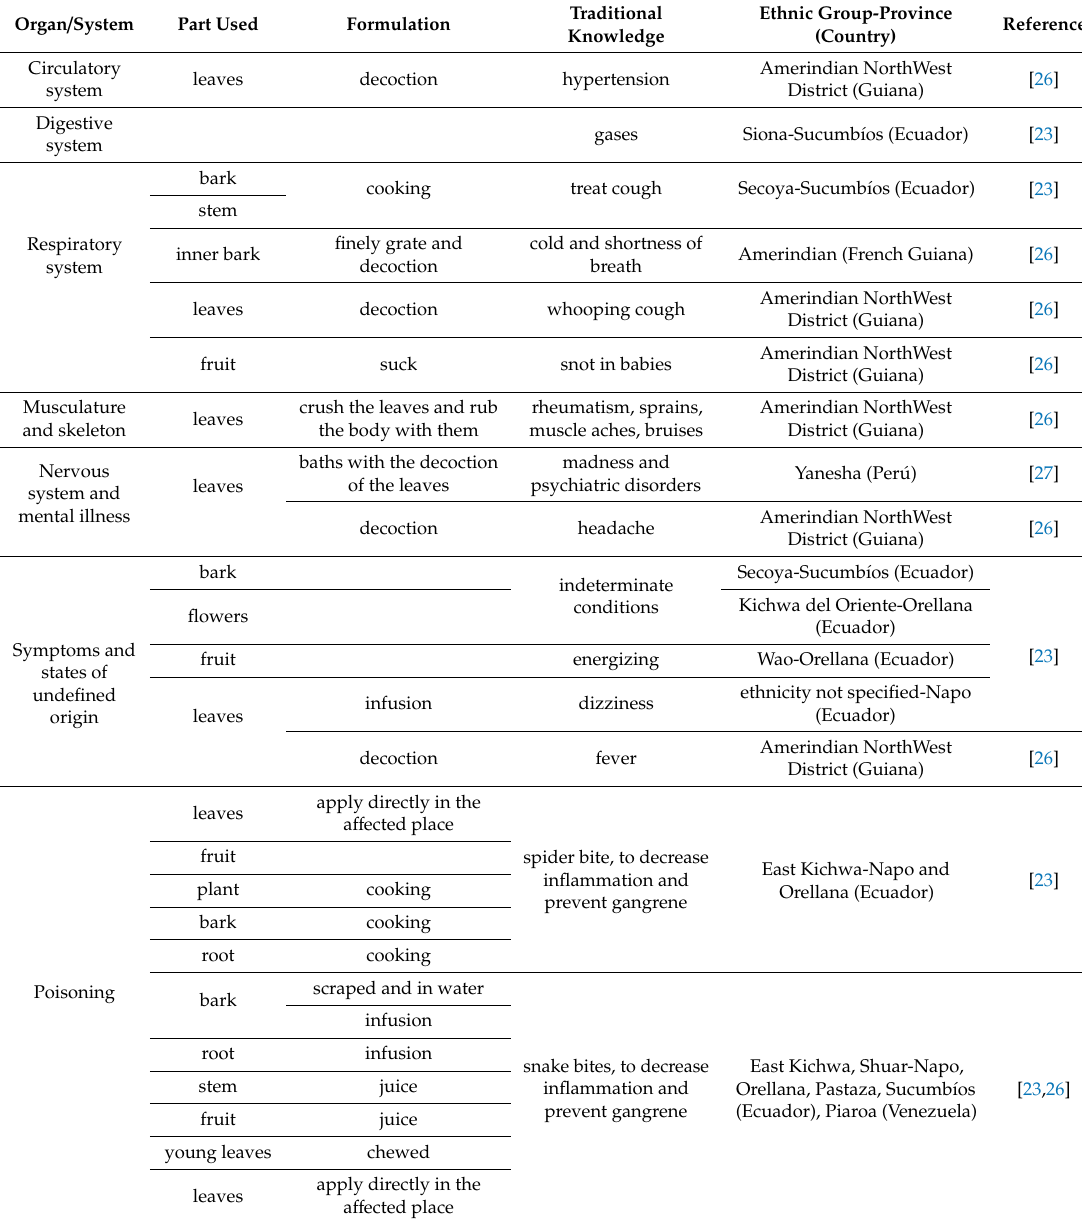
Table 1. Medicinal uses given to the species retrieved from our fieldwork prospections and literature